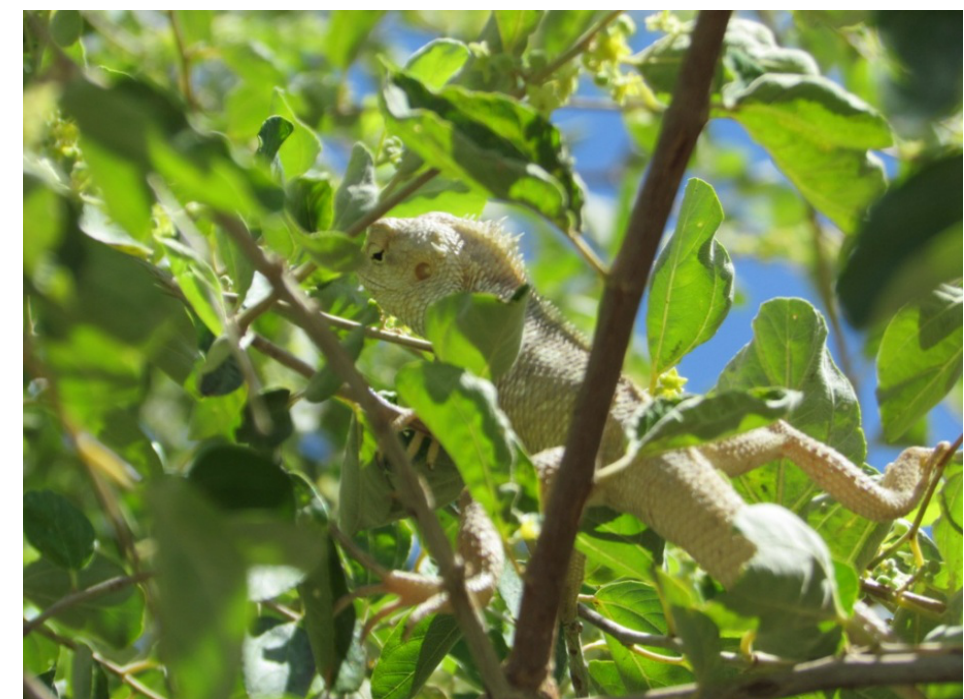
F IGURE 3. Adult of Calotes versicolor in Gervani village on Christ Thorn ( Zizphus spina-christi , Sistan and Baluchestan province, Iran (Photo by: A.Mobaraki) (ZMGU. 2776, c aptured).